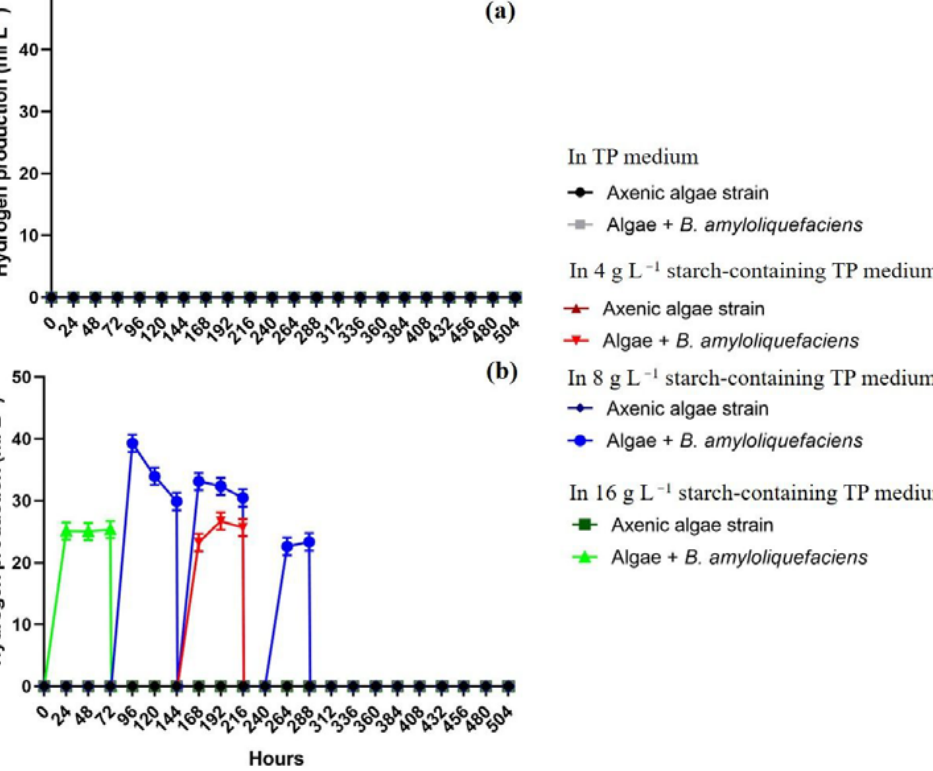
Figure 3. Continuous hydrogen production of C. reinhardtii cc124 ( a ) and Chlorella sp. MACC-360 ( b ) in acetate-free TP medium (the initial bacterial OD 600 of 0.07). Hydrogen was measured in the headspace at every 24 h. Bottles were aerated for 5 min after hydrogen measurement at every 72 h. Error bars are standard deviations based on three replicates.